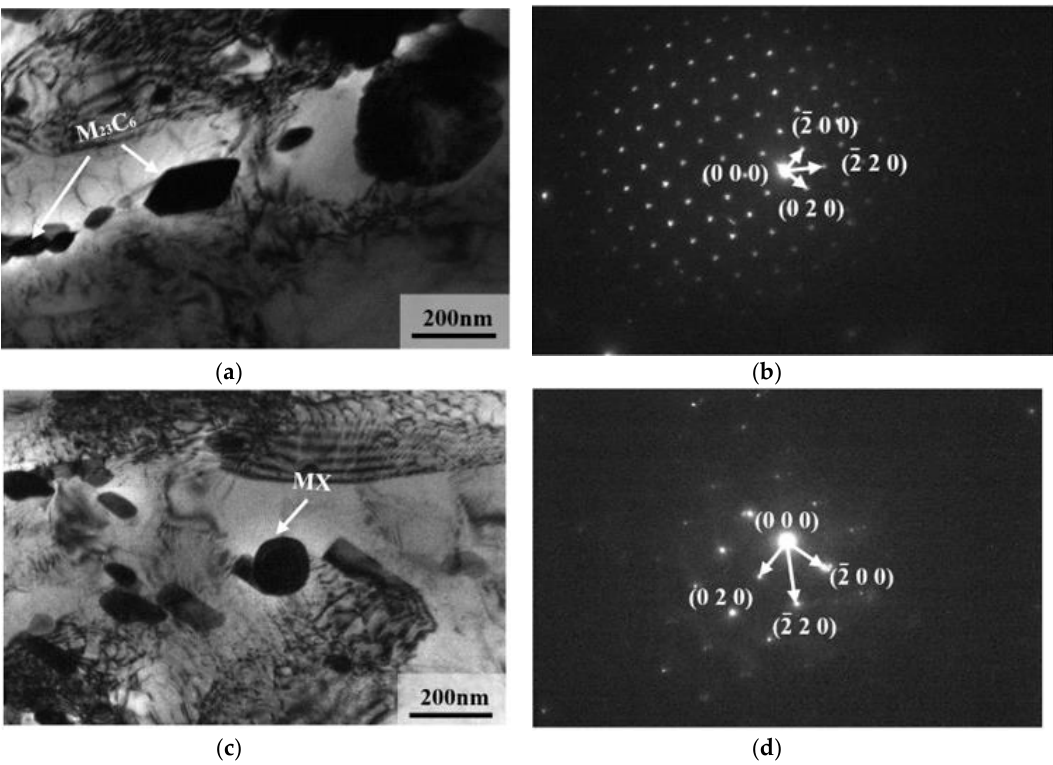
Figure 13. TEM image of precipitation phase in 9Cr–3W–3Co heat-resistant steel: ( a ) the morphology of M 23 C 6 precipitates, ( b ) diffraction pattern of M 23 C 6 precipitates, ( c ) the morphology of MX precipitates, ( d ) diffraction pattern of MX precipitates